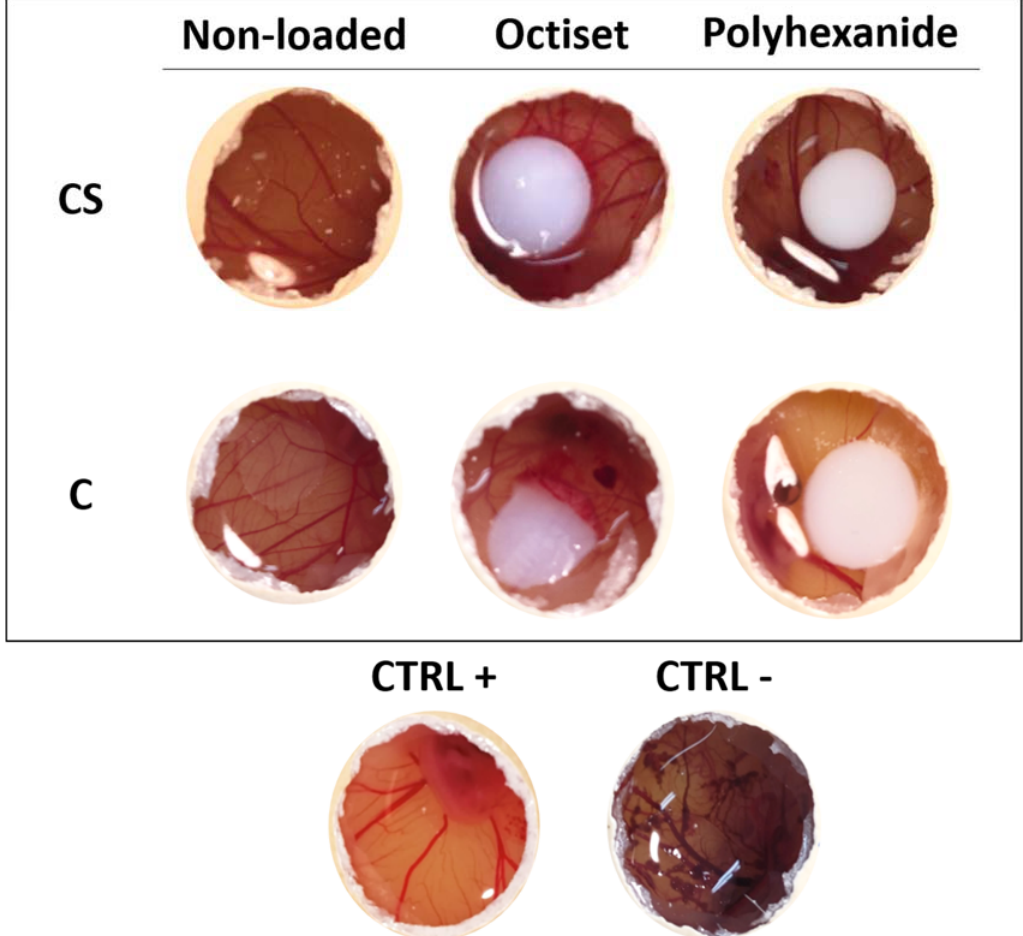
Figure 8. Chorioallantoic membrane images after 5 min contact with CS and C hydrogels, non-loaded and loaded with Octiset ® and with polyhexanide. Images of negative control and positive control are included. The non-loaded disks are transparent, while the drug-loaded ones are whitish.